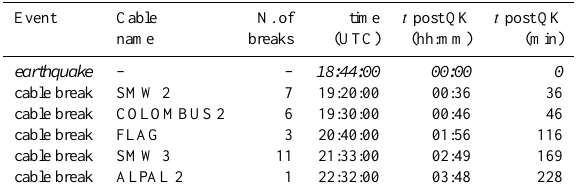
Table 1. Time of rupture of five submarine cables offshore the cen- tral Algerian margin (France Telecom, personal communication, 2003) after the earthquake (QK) of Boumerd`es, 21 May